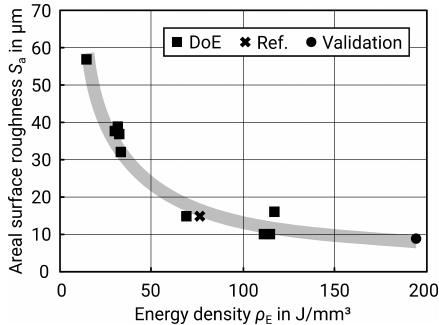
Figure 9. Surface roughness S a plotted versus energy density ρ E for upskin surfaces (including nine values as a result of the DoE, one value as a reference (see Table 7) and one value from the validation; grey line for clarification purposes